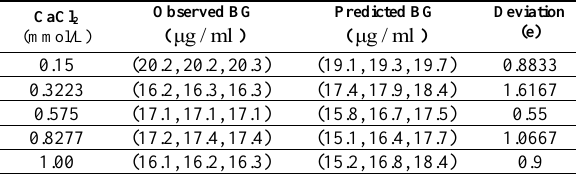
Table 10. Predicted BG content and deviations for CaCl 2